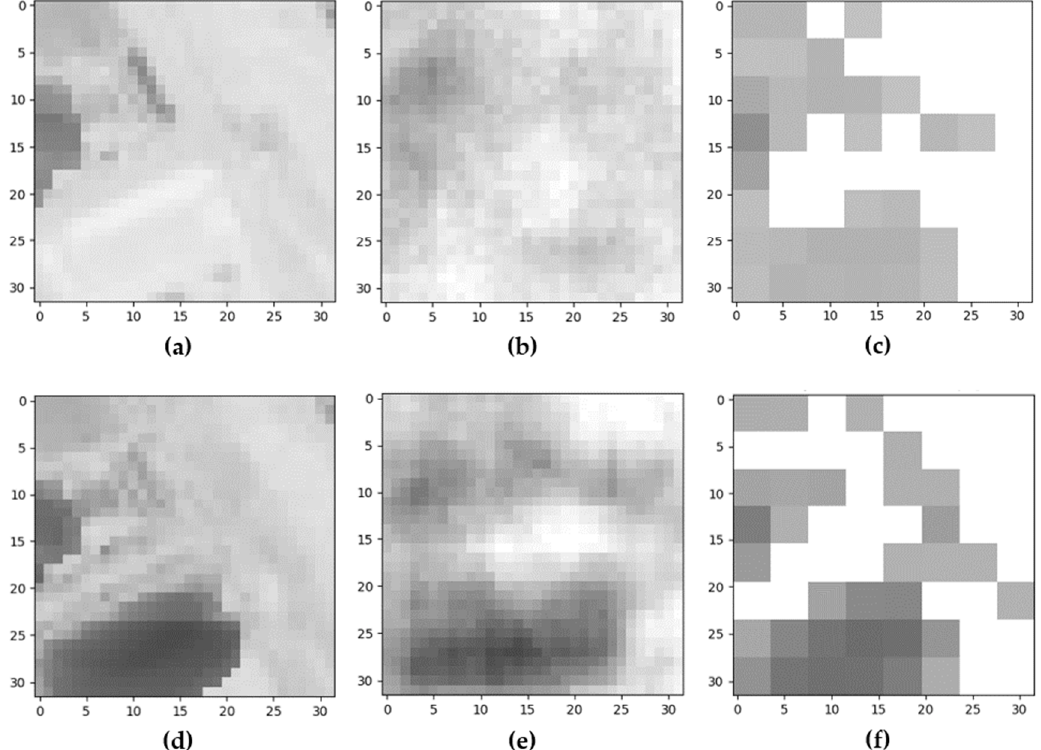
Figure 9. Comparison between the reconstructed images: ( a ) original patch at time t 1 ; ( b ) patch reconstruction through the AANN model; ( c ) patch reconstruction through DWT; ( d ) original patch at time t 2 ; ( e ) patch reconstruction through the AANN model; ( f ) patch reconstruction through DWT.